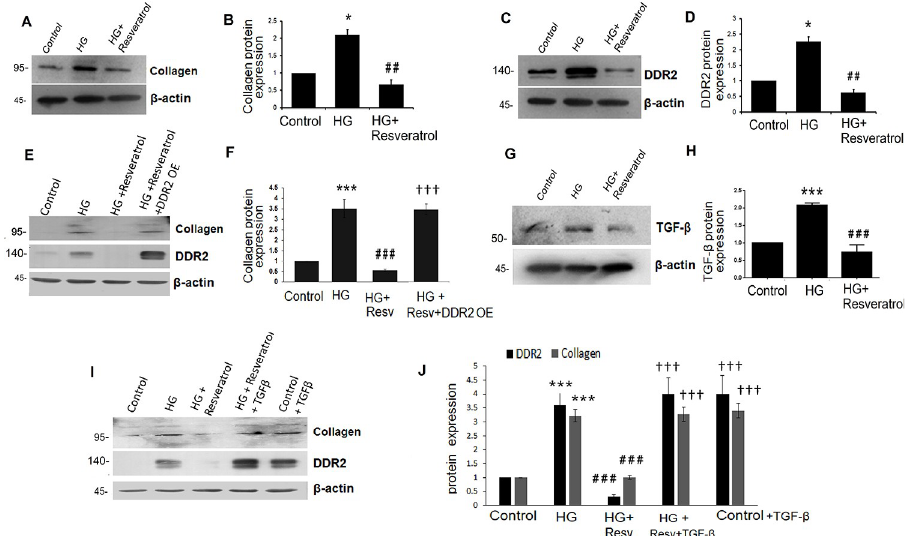
Fig 7. Resveratrol prevents HG-induced collagen type I and DDR2 in VSMCs. ( A-D & G,H) Resveratrol prevents HG-induced collagen type I alpha 1, DDR2 and TGF- β 1 expression in VSMCs. Pre-treatment of cells with 50 μ M resveratrol followed by HG for 12 h reduced: (A and B) HG-induced increase in collagen type I alpha 1 expression. � p < 0.05 vs control, ## p < 0.01 vs HG (One-way ANOVA p < 0.05). ( C and D) HG-induced increase in DDR2 expression. � p < 0.05 vs control, ## p < 0.01 vs HG (One-way ANOVA p < 0.05). (E and F) Vascular smooth muscle cells were transiently transfected with DDR2 overexpression vector. Post-transfection, following revival and serum deprivation, the cells were pre-treated with resveratrol for 1 h, followed by stimulation with HG for 12 h. Collagen type I alpha 1 protein was examined by western blot analysis. ��� p < 0.001 vs. control, ### p < 0.001 vs. HG, ††† p < 0.001 vs. HG+RESV. (G and H) HG-induced increase in TGF- β 1 protein expression. ��� p < 0.001 vs. control, ### p < 0.001 vs. HG (One-way ANOVA p < 0.05). (I and J) Vascular smooth muscle cells were pre-treated with resveratrol for 1 hr, followed by stimulation with HG and exogenously added recombinant TGF- β 1. Protein expression levels of collagen type I alpha 1 and DDR2 were examined at 12 h by western blot analysis. ��� p < 0.001 vs. control, ### p < 0.001 vs. HG, ††† p < 0.001 vs. HG+RESV (For DDR2 and collagen type 1 alpha 1). (One-way ANOVA p < 0.05). Data are representative of three independent experiments with SD, n = 3. Error bars represent SD.